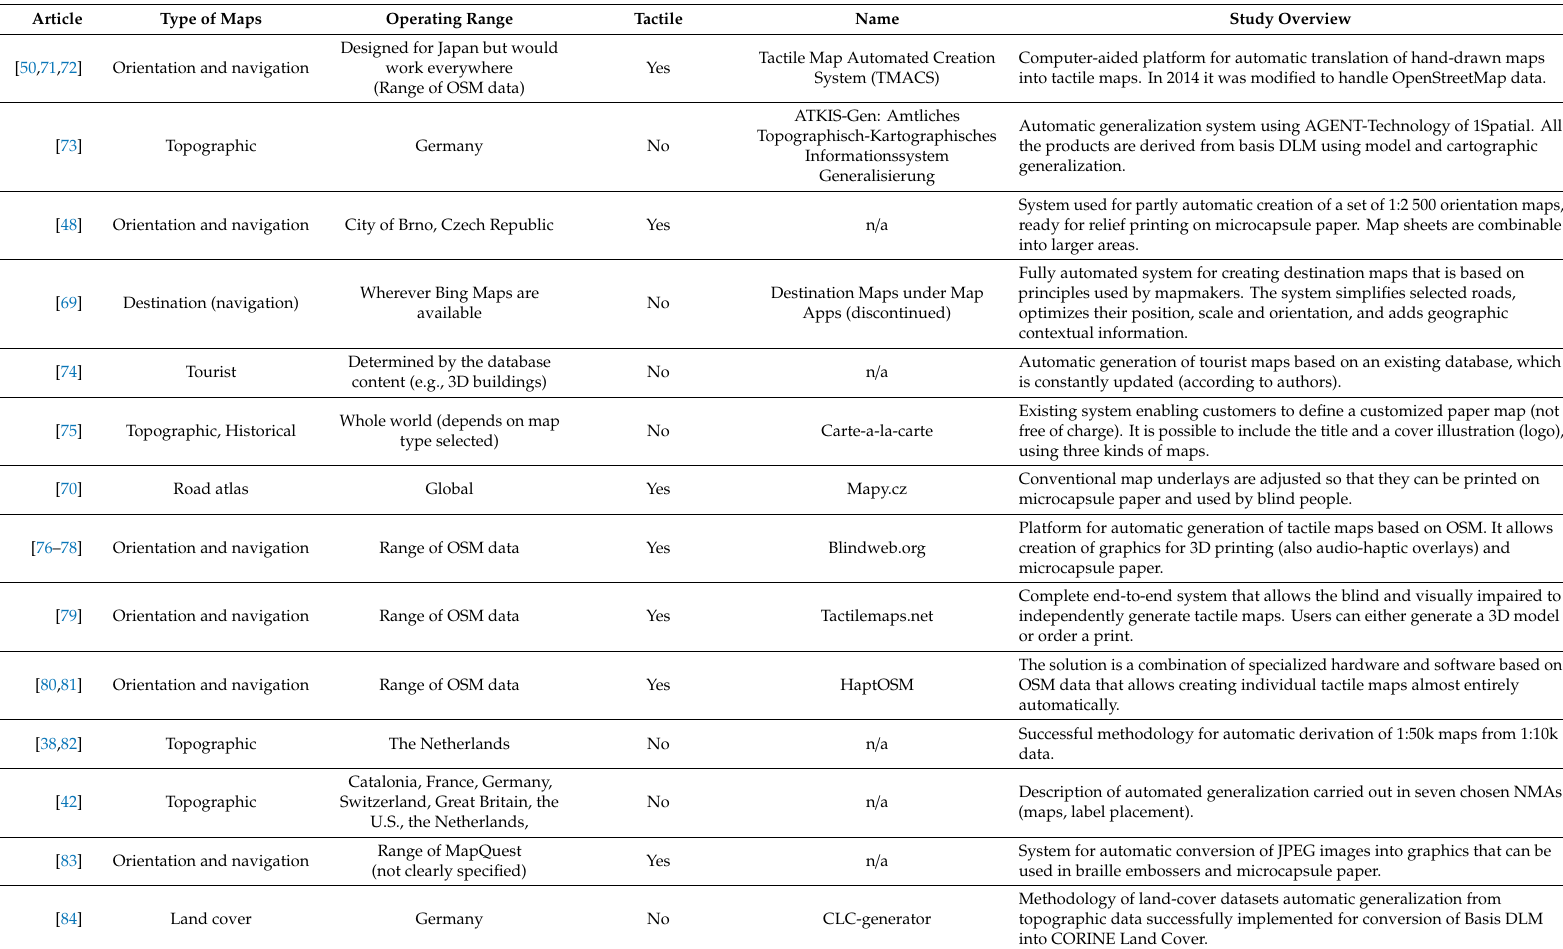
Table 3. Existing systems and solutions allowing automatic (tactile) map generation (source: own